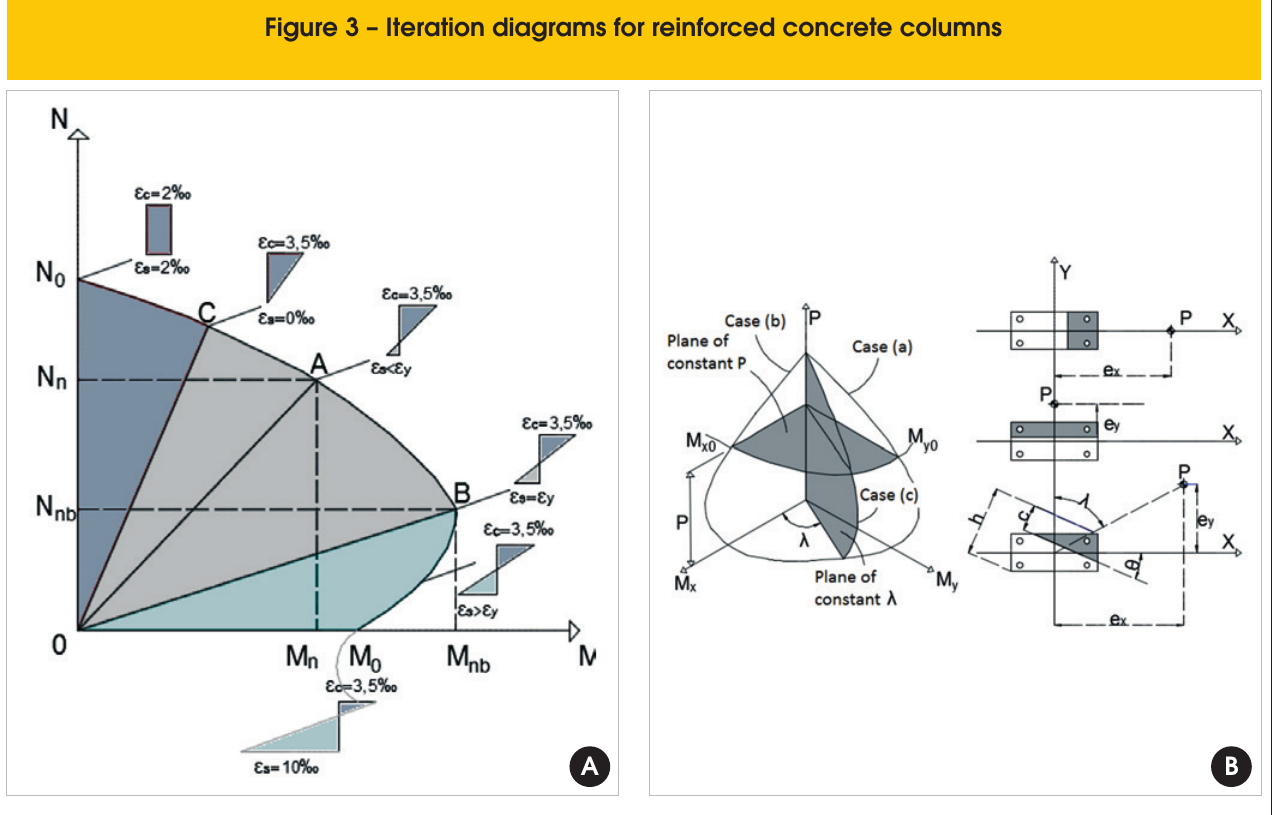
Figure 3 – Iteration diagrams for reinforced concrete columns